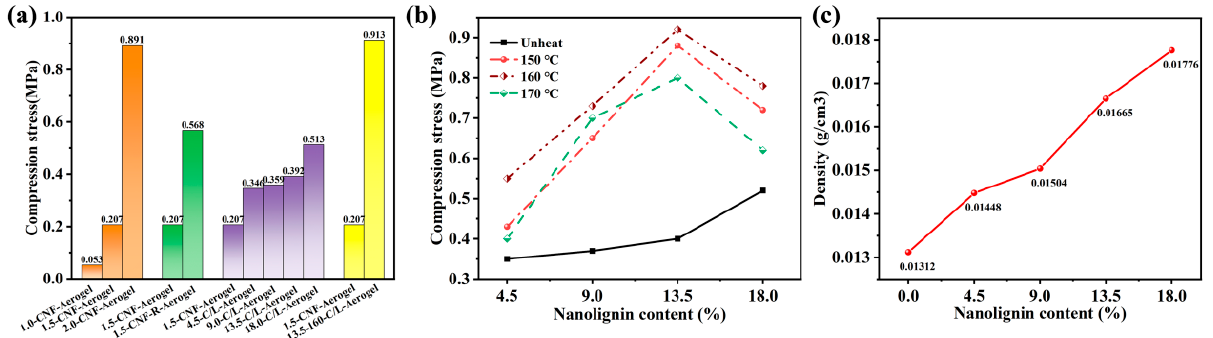
Figure 3. Compression properties of prepared aerogels. ( a ) Compression stress of 1 wt% CNF-aerogel, 1.5 wt% CNF-aerogel, 1.5 wt% CNF-aerogel with resin, 2 wt% CNF-aerogel, and 1.5 wt% 160-CNF/lignin-aerogel. ( b ) Compression stress of CNF/lignin-aerogel treated with different